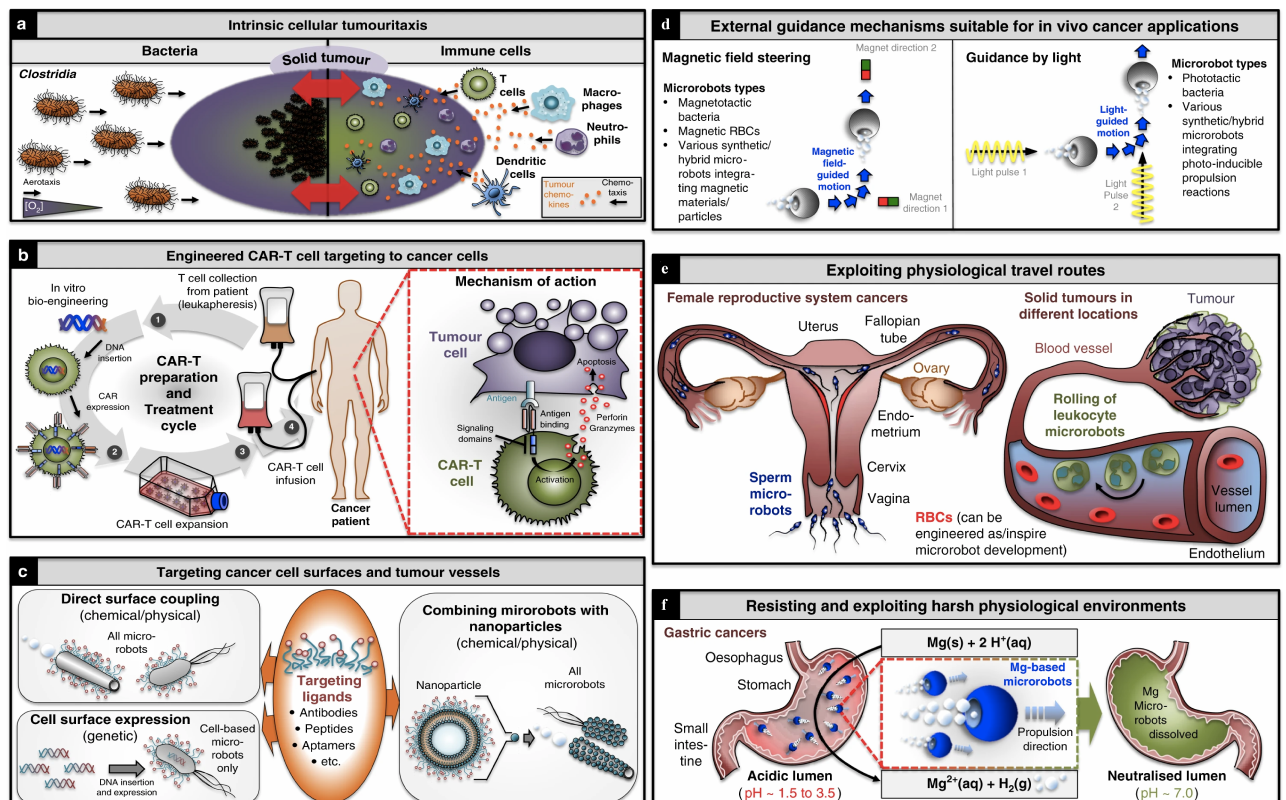
Figure 2. Targeted drug delivery: ( a ) Bacteria, such as Clostridia , and higher eukaryotic immune cells exhibiting intrinsic tumouritaxis, ( b ) FDA-approved pipeline for producing CAR-T cells as a tailored cancer therapy (left). CAR-T cells target cancer cells by identifying tumor antigens on their surface, resulting in downstream TCR signaling such as cytotoxic perforin and granzyme responses ( c ) Direct surface coupling or combining microbots with nanoparticles as showed for nanoliposomes, ( d ) Magnetic and light assisted external guidance for the microbots to reach the targeted region, ( e ) Biohybrid microbots such as sperm coated with nanoparticles to target the cancer cells in the female reproductive system for easy access, and ( f ) The acidic environment inside the stomach lumen is neutralized using chemically activated microbots. Notes—RBCs: red blood cells, aq: aqueous, and g: gaseous [71]. Reproduced under the terms of the CC-BY